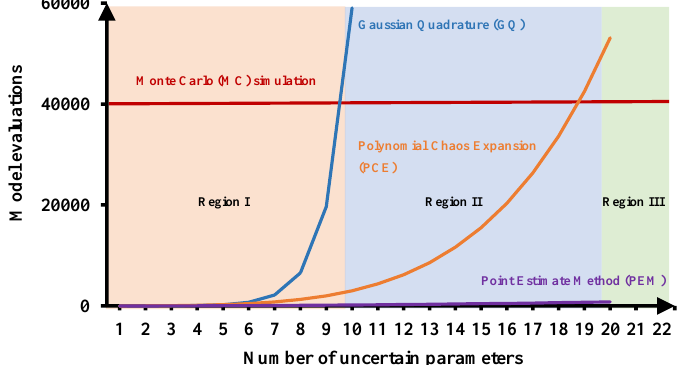
Figure 1. Computational demand (i.e., number of model evaluations) for different uncertainty quantification methods with increasing number of uncertain parameters and the same system complexity to achieve similar approximation